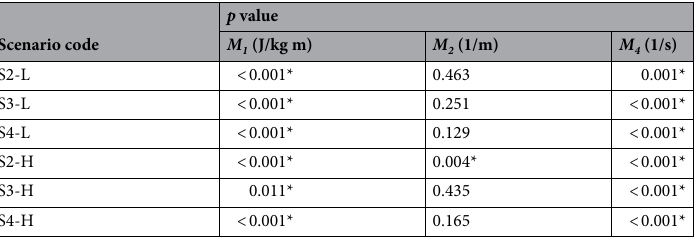
Table 2. p-values associated with changing the grid spacing from 0.06 to 0.24 m. M 1 is the kinetic energy gradient metric, M 2 is the normalized kinetic energy gradient metric, and M 4 is the modified recirculation metric. (*) indicates the change is statistically significant assuming a significance level of 0.05.